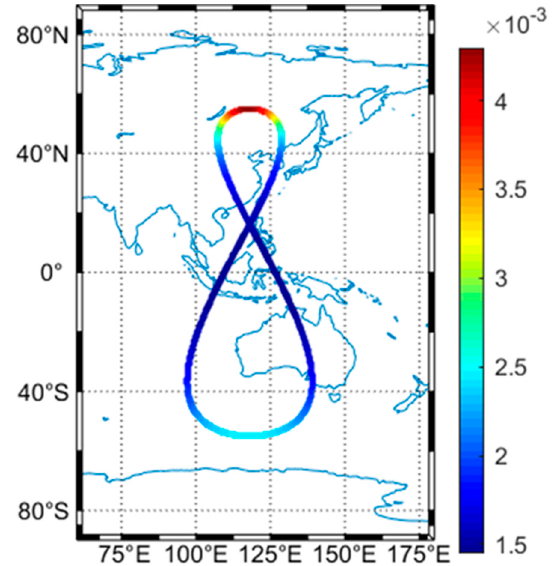
Figure 2. Distribution of observing probability for three Quasi-Zenith orbit (QZO) satellites.